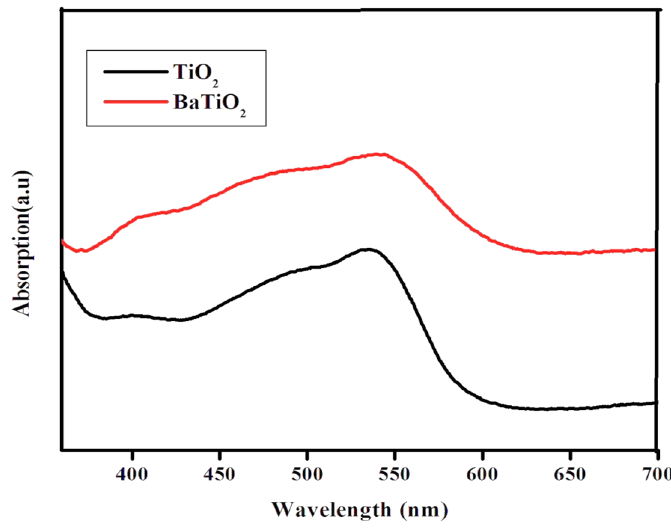
Figure 4. UV-visible absorption spectra of synthesized TiO 2 and Ba/TiO 2 photoanodes with N3 dye molecule.